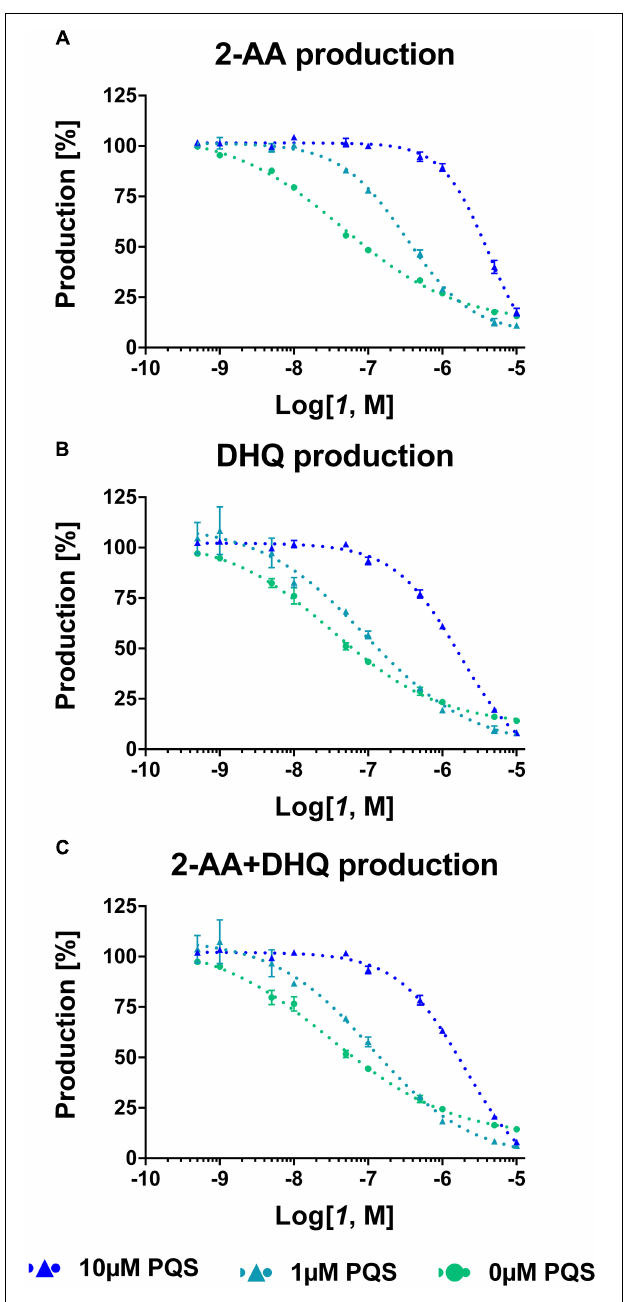
FIGURE 4 | Dose-response curves of MvfR antagonist 1 on 2-AA (A) , DHQ (B) and overall (C) production in PA14 pqsC mutant with and without external addition of PQS. The “ x ” axes indicate the logarithm of the concentration of the antagonists in molar units (M). The error bars indicate Standard Error of the